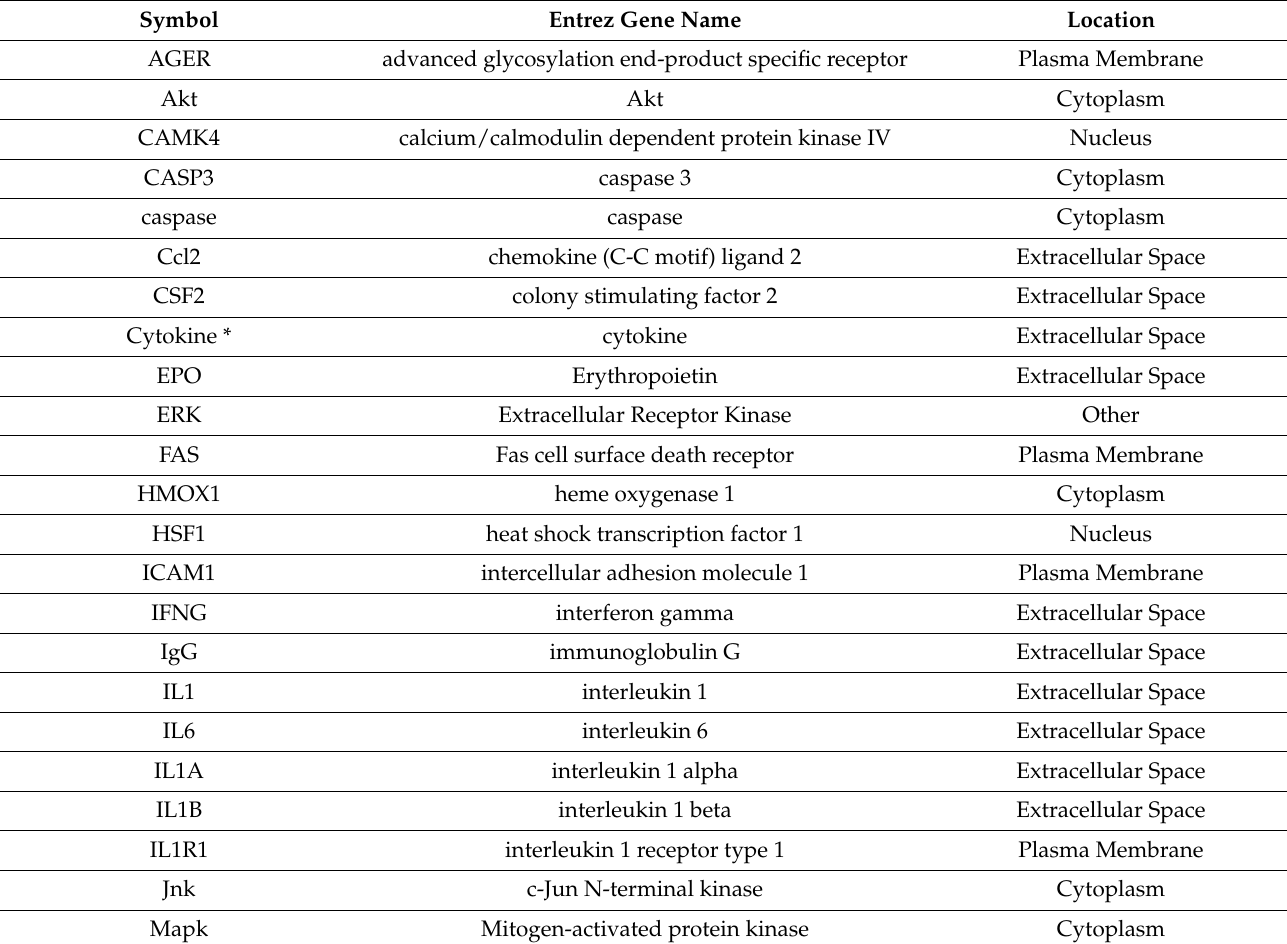
Figure 6. Integrated network of the METH, HMGB1, and APP intermediate molecules. The pathways between the 16 intermediate molecules influencing HMGB1 expression upon METH exposure and the 19 molecules mediating HMGB1 and APP were integrated into one network that illustrates the relationships of the molecules in the presence of each other. For a full list of molecules see Table 1. Table 1. List of the 35 total molecule mediating METH, HMGB1, and APP